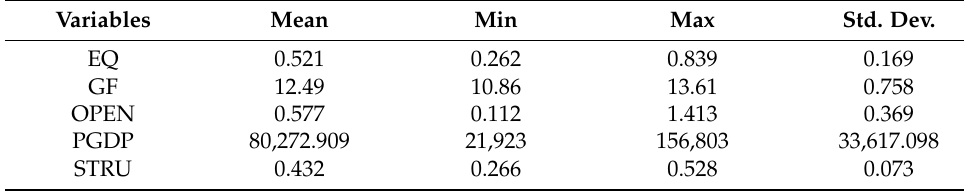
Table 4. Descriptive statistics of each variable.